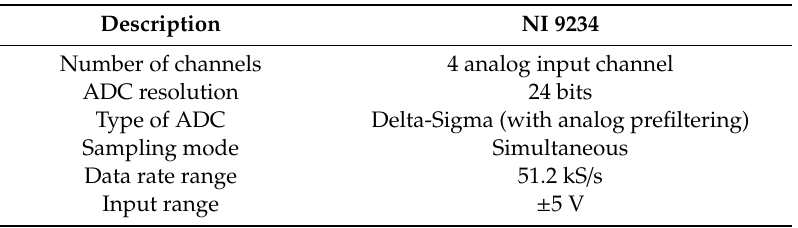
Table 3. NI 9234